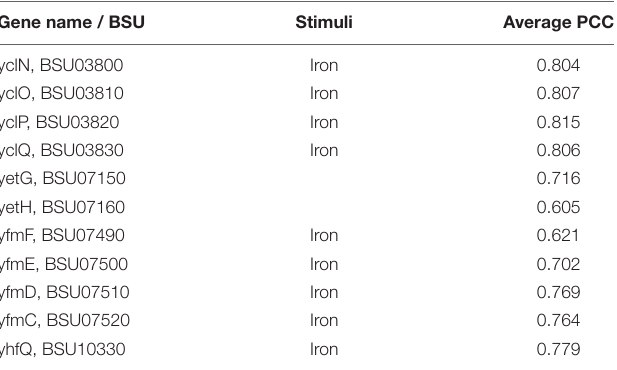
TABLE 6 | Atomic Regulon